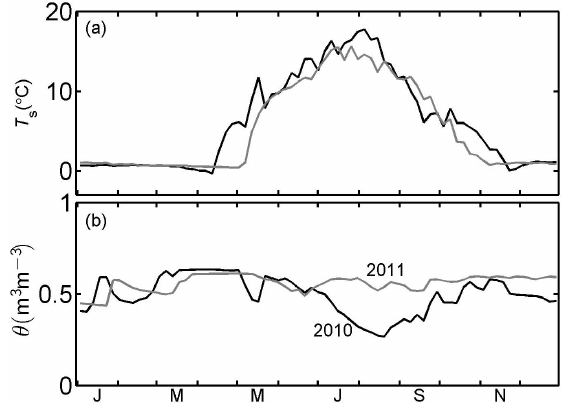
Fig. 3. Interannual variability in (a) 5-day averaged soil temperature ( T s ) and (b) volumetric soil water content ( θ) at the 3cm depth at MPB-09 for 2010 and